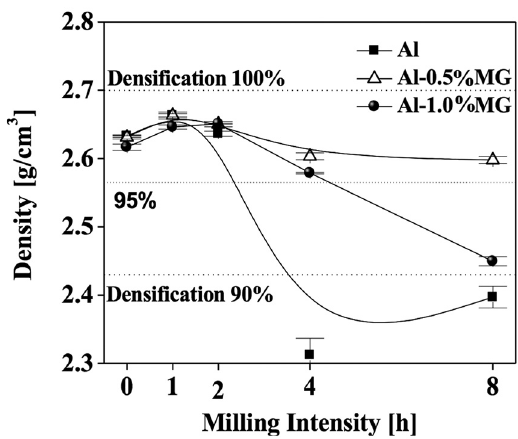
Figure 5. Density variation of sintered samples as a function of the milling time and MG addition.